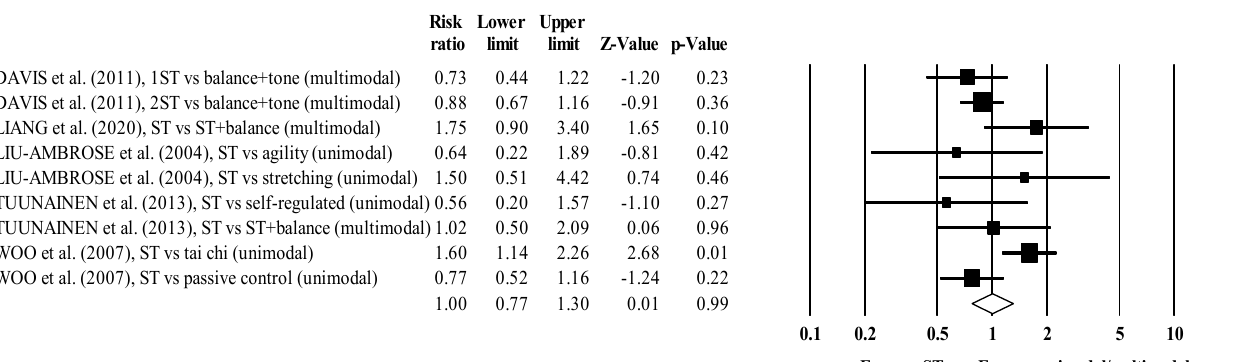
Table 3. Risk of bias within studies. D1—Randomization process. D2—Deviations from intended intervention—effect of assignment to intervention. D3—Missing outcome data. D4—Measurement of the outcome. D5—Selection of the reported result. Low risk of bias. Some con- cerns. High risk of bias.